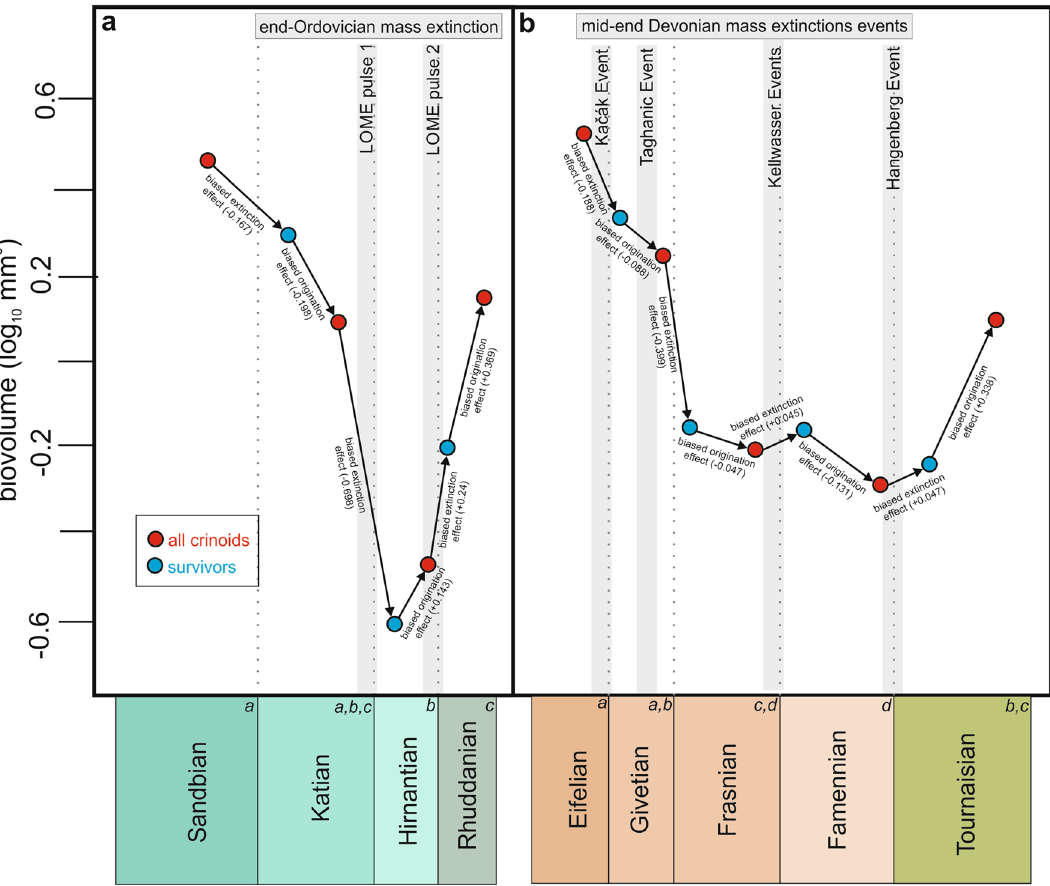
Figure 3. Plots explaining the calculation of the two major component values (biased extinction, biased origination). Interpretation of these plots works as follows, using the late Katian extinction as an example (a) and the late Givetian extinction as an example (b) . (a) In the Katian, 55 genera were extant; their mean biovolume size was 0.0874 log mm 3 . Of these 55 genera, 43 went extinct in this stage (with the mean size 0.282 log mm 3 ), and 12 survived into the Hirnantian (the mean size of these −0.611 log mm 3 ). Therefore, on average the survivors were smaller than the extinction victims. Thus, extinction was size-biased (larger genera were more likely to go extinct). The change in mean size due to this size-biased extinction was −0.611 log mm 3 — 0.0874 log mm 3 = − 0.6984 log mm 3 . In the Hirnantian, only 4 new genera originated with mean size −0.042 log mm 3 . The mean size in the Hirnantian of all 16 genera (12 survivors from the Katian and 4 originators) is −0.468 log mm 3 . Thus the 4 new originators changed the mean size of genera extant in the Hirnantian from −0.611 log mm 3 to −0.468 log mm 3 (a difference of 0.143 log mm 3 ). In summary, the mean size of Katian taxa is 0.0874 log mm 3 , and the mean size of Hirnantian taxa is −0.468 log mm 3 , a change of −0.555 log mm 3 . This change of -0.555 log mm 3 is partitioned into a size-biased extinction component of −0.6984 log mm 3 . Origination of new genera during the Hirnantian with mean size 0.143 log mm 3 slightly mitigated the size decrease imposed by extinction component. Note that −0.6984 – (−0.143) = − 0.555. ( b ) In the Givetian, 75 genera were extant with the mean biovolume 0.254 log mm 3 . Of these 75 genera, 55 went extinct in this stage (with the mean size 0.4 log mm 3 ), and 20 survived into the Frasnian (with the mean size −0.145 log mm 3 ). Thus, extinction was size-biased (larger genera preferentially went extinct). The change in mean size due to this size-biased extinction was −0.145 log mm 3 −0.254 log mm 3 = 0.399 log mm 3 . In the Frasnian, 46 new genera originated with mean size -0.213 log mm 3 . The mean size in the Frasian of all 66 genera (20 survivors from the Givetian and 46 originators) is −0.192 log mm 3 . Thus the 46 new originators changed the mean size of genera extant in the Frasnian from −0.145 log mm 3 to −0.192 log mm 3 (a difference of 0.047 log mm 3 ). In summary, the mean size of Givetian taxa is 0.254 log mm 3 , and the mean size of Frasian taxa is -0.192 log mm 3 , a change of −0.446 log mm 3 . This change of −0.446 log mm 3 is partitioned into a size-biased extinction component of −0.399 log mm 3 and a size-biased origination component of −0.047 log mm 3 . Note that −0.399−0.047 = −0.446. Periods sharing the same superscript indicate that size distributions are not significantly different from each other (p >